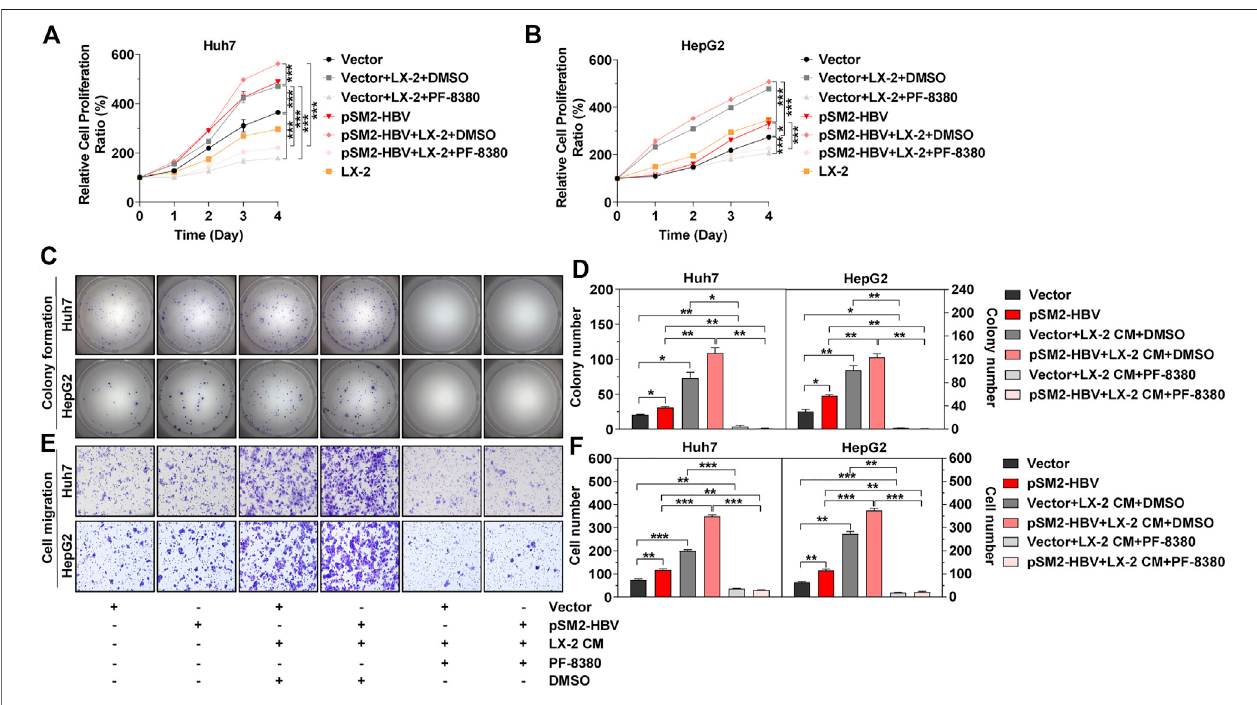
FIGURE5| ActivatedHSCstrengthensHCCprogressioninducedbyHBV.HepatomacellsweretransfectedwithvectororpSM2-HBVfor1 day(setasday0)and then co-cultured with LX-2 or treated with LX-2 CM containing DMSO or PF-8380. (A, B) Cell proliferation abilities for Huh7 (A) or HepG2 (B), respectively. (C) Representative images of colony formation for Huh7 (upper panels) and HepG2 (below panels) , respectively. (D) The bar graph of colony number indicated quantitative analysis data for Huh7 (left panel) and HepG2 (right panel) , respectively. (E) Representative images of the cell migration assay for Huh7 (upper panels) andHepG2 (belowpanels) ,respectively(magni fi cation × 100). (F) ThebargraphofcellnumbermigratedfromTranswellindicatedquantitativeanalysisdatafor Huh7 (left panel) and HepG2 (right panel) , respectively. The statistical analysis was based on three replicates. *, p < 0.05; **, p < 0.01; ***, p <